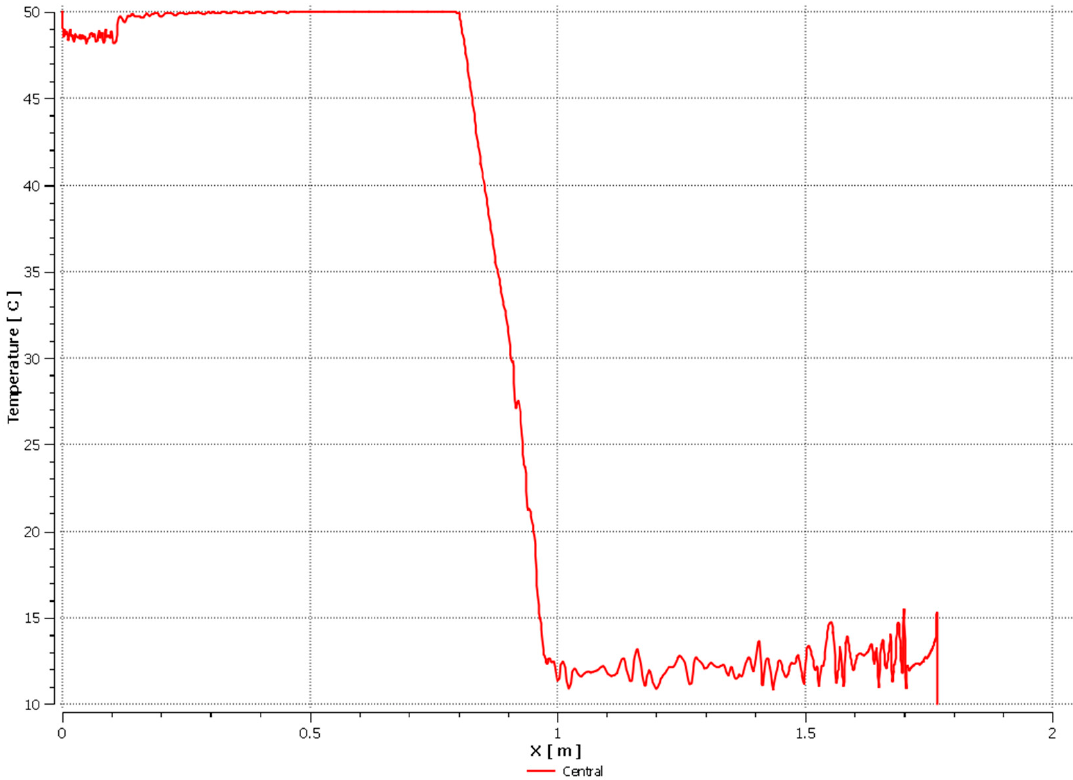
Figure 11. Temperature distribution along the height of the heat pipe’s wall.